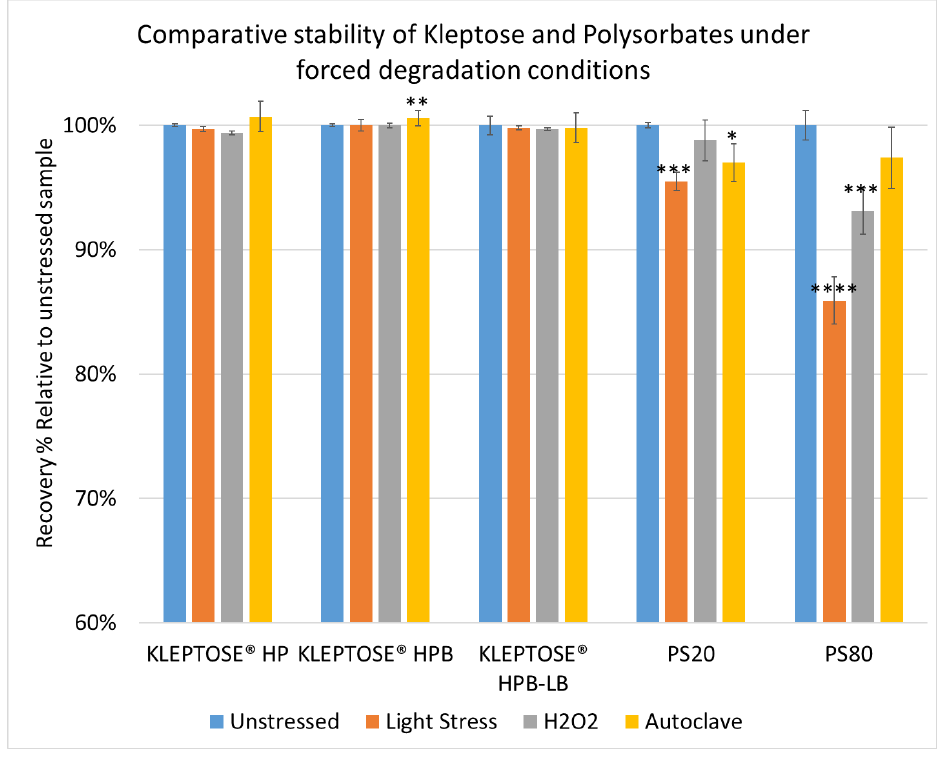
Figure 6. Comparative stability of KLEPTOSE ® HP, HPB and HPB-LB, PS 20, and PS 80 under autoclave, oxidative, and light stresses. * p < 0.05, ** p < 0.01, *** p < 0.001, and **** p < 0.0001.